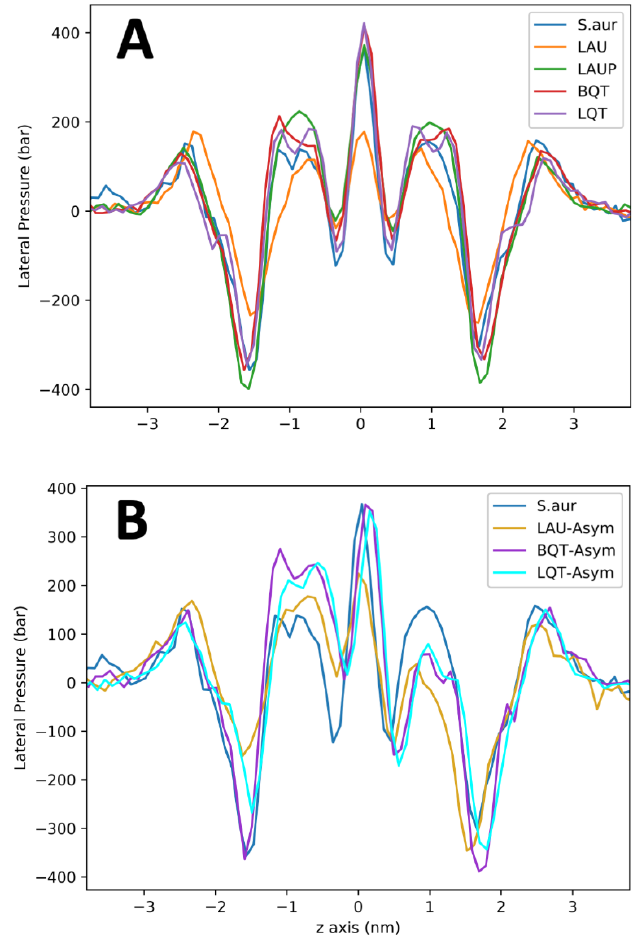
Figure 5. Lateral pressure profiles for symmetric ( A ) and asymmetric ( B ) distributions of molecules in the S. Aureus membrane. The asymmetric membranes contain the surfactants in the lower monolayer (i.e., -ve z).